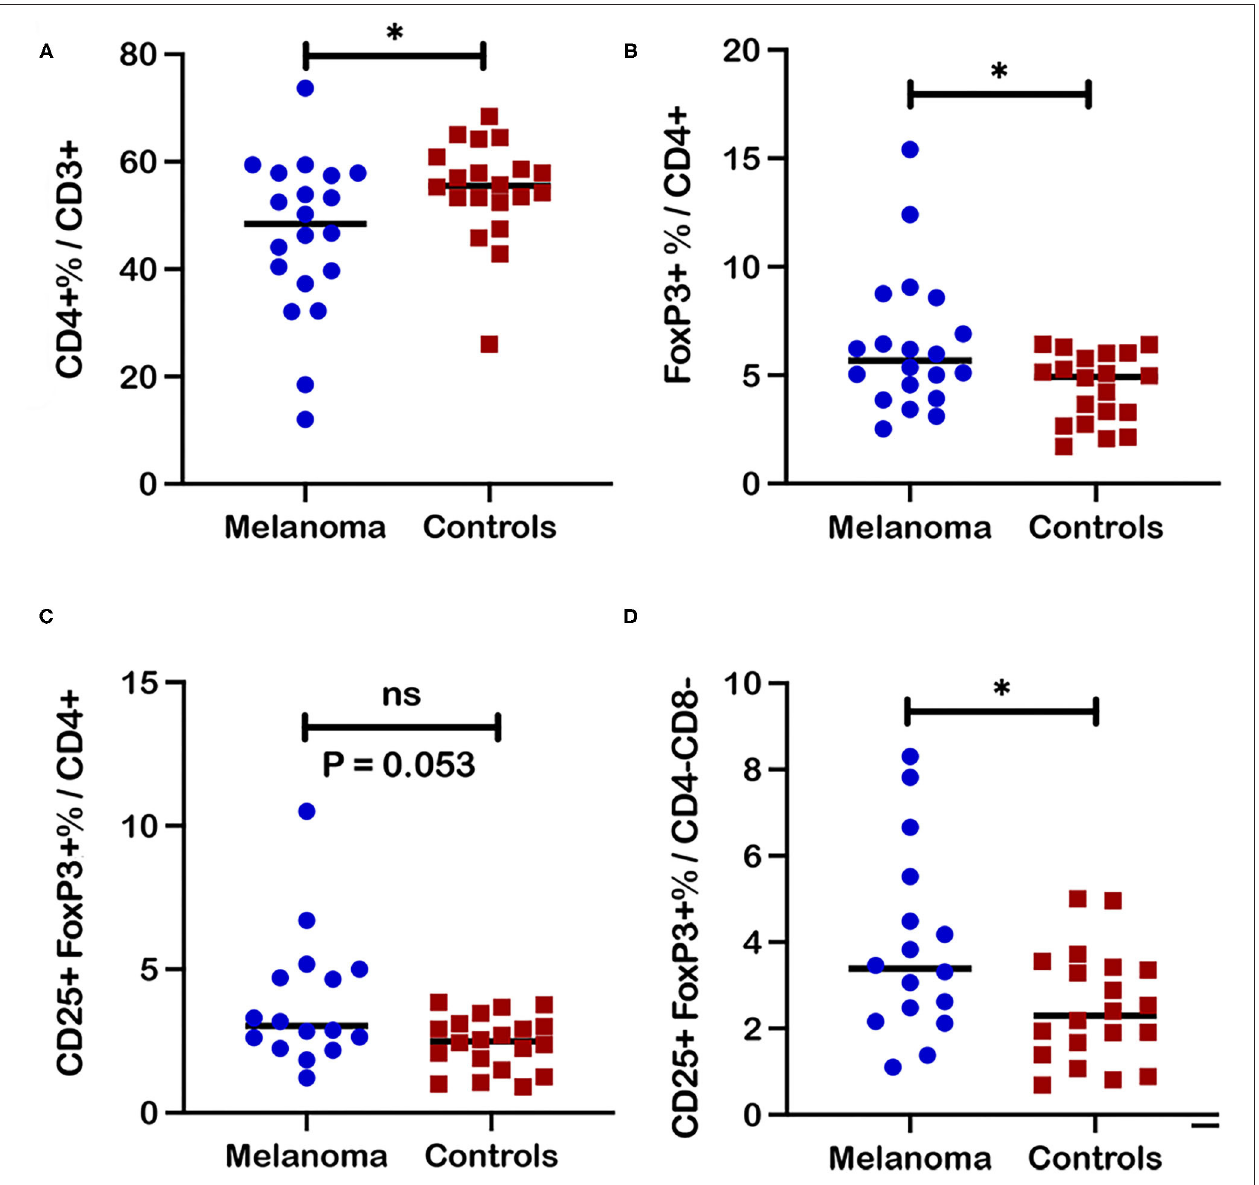
FIGURE 3 | Frequencies of regulatory T cell subsets in blood from canine melanoma patients and healthy controls. (A) A comparison of median frequencies for CD4 + cells within the T cell population for patients and controls is shown. (B) Median frequencies of FoxP3 + and (C) CD25 + FoxP3 + cells within the CD4 + T cell population are also compared between patients and healthy controls. (D) Median frequencies of CD25 + FoxP3 + cells within the CD4-CD8- T cell population are compared between patients and healthy controls. Pair-wise analysis between patients and controls was conducted with the Mann Whitney test using GraphPad Prism software and two-tailed analysis. “ns” denotes not significant. A single asterisk (*) denotes a P -value < 0.05. P -values < 0.05 are considered